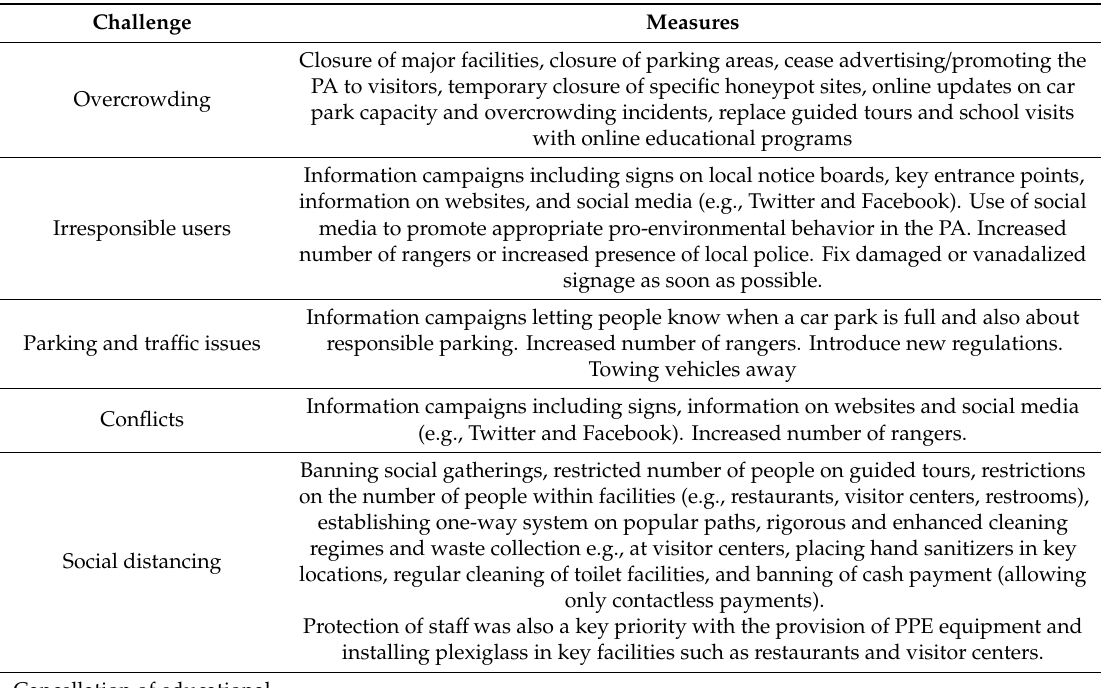
Table 3. Measures to tackle new challenges due to